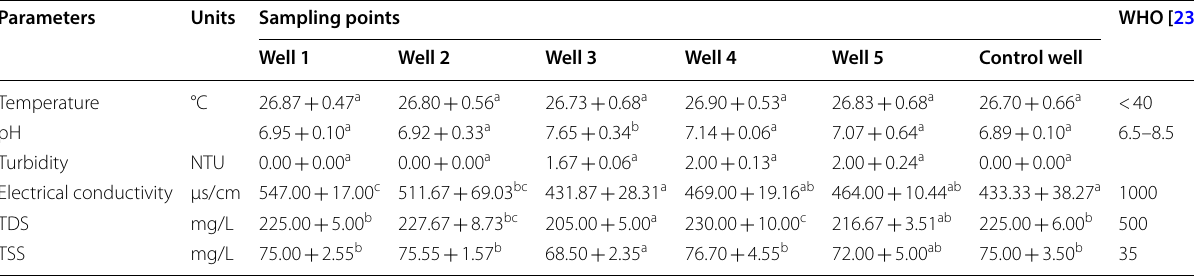
For each parameter, means with the different letters (superscripts) are significantly different ( p < 0.05), using Duncan’s multiple range test